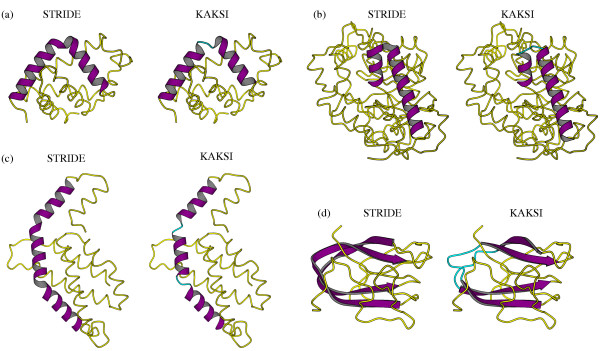
Examples of disagreement between kaksi and stride. The divergent assignments are drawn in cartoon representation and highlighted in purple (helix and strand) and cyan (coil assigned by KAKSI). Images are generated with Molscript [46]. Average bending angles (AverBA) between local axes computed by HELANAL in long helices are reported, (a): hemoglobin I from the clam Lucina pectinata, PDB code:1b0b, resolution 1.43 Å. STRIDE assignment: α-helix from residues 4 to 35, AverBA = 15.4°. KAKSI assignment: two helices from 4 to 19, AverBA = 3.84° and 21 to 34, AverBA = 9.0°. (b): chain A of L(+)-mandelate dehydrogenase from Pseudomonas putida, PDB code: 1p4c, resolution 1.35 Å. STRIDE assignment: helix from 308 to 340, AverBA = 24.7°. KAKSI assignment: two helices from 308 to 315 and 320 to 341, AverBA = 4.3°. (c): chain B of C-phycocyanin from the thermophylic cyanobacterium Synechococcus elongatus, PDB code: 1jbo, resolution: 1.45 Å. STRIDE assignment: helix from residues 21 to 62, AverBA = 13.1°. KAKSI assignment: 3 helices from 21 to 33, AverBA = 4.5°, 35 to 46, AverBA = 3.0°, and 48 to 61, AverBA = 6.6°. (d): chain A from endo-xylanase from Clostridium stercorarium, PDB code: 1od3, resolution: 1 Å. STRIDE assignment: two β-strands from 61 to 82 and 116 to 135. KAKSI assignment: four β-strands from 61 to 69, 75 to 83, 115 to 122, and 128 to 136.